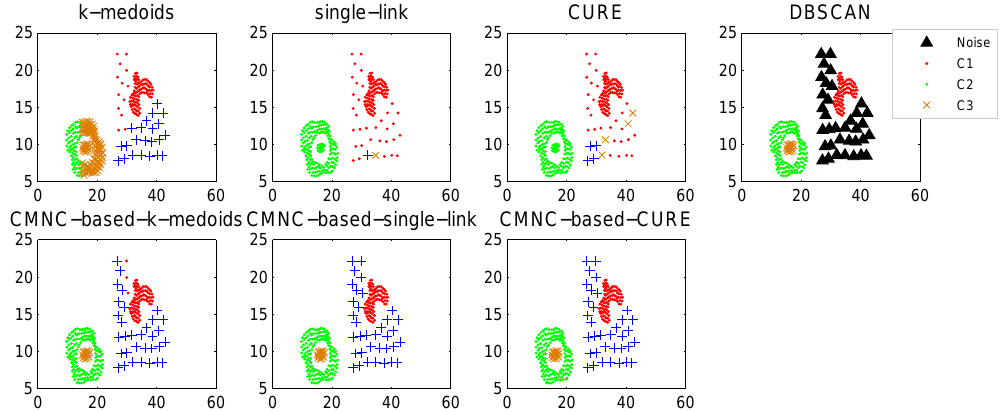
Figure 10. Comparison of clustering results on the “compound”